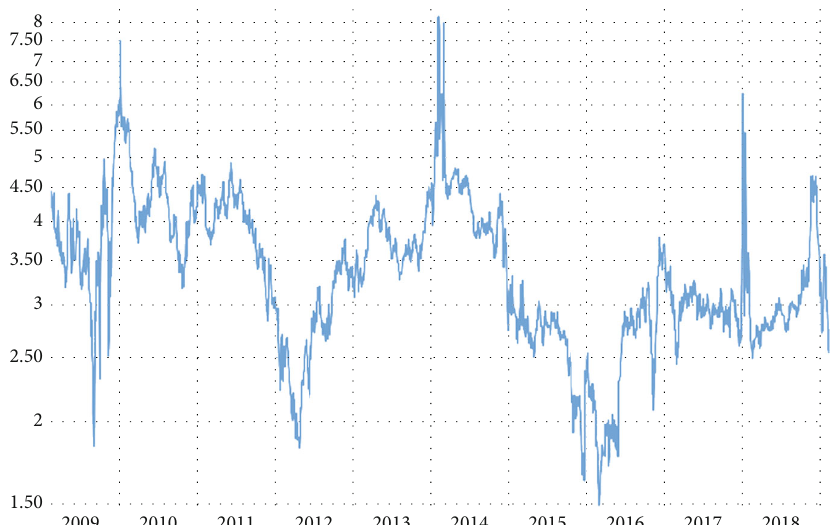
Figure 9: Historical natural gas price chart is shown in U.S. dollars